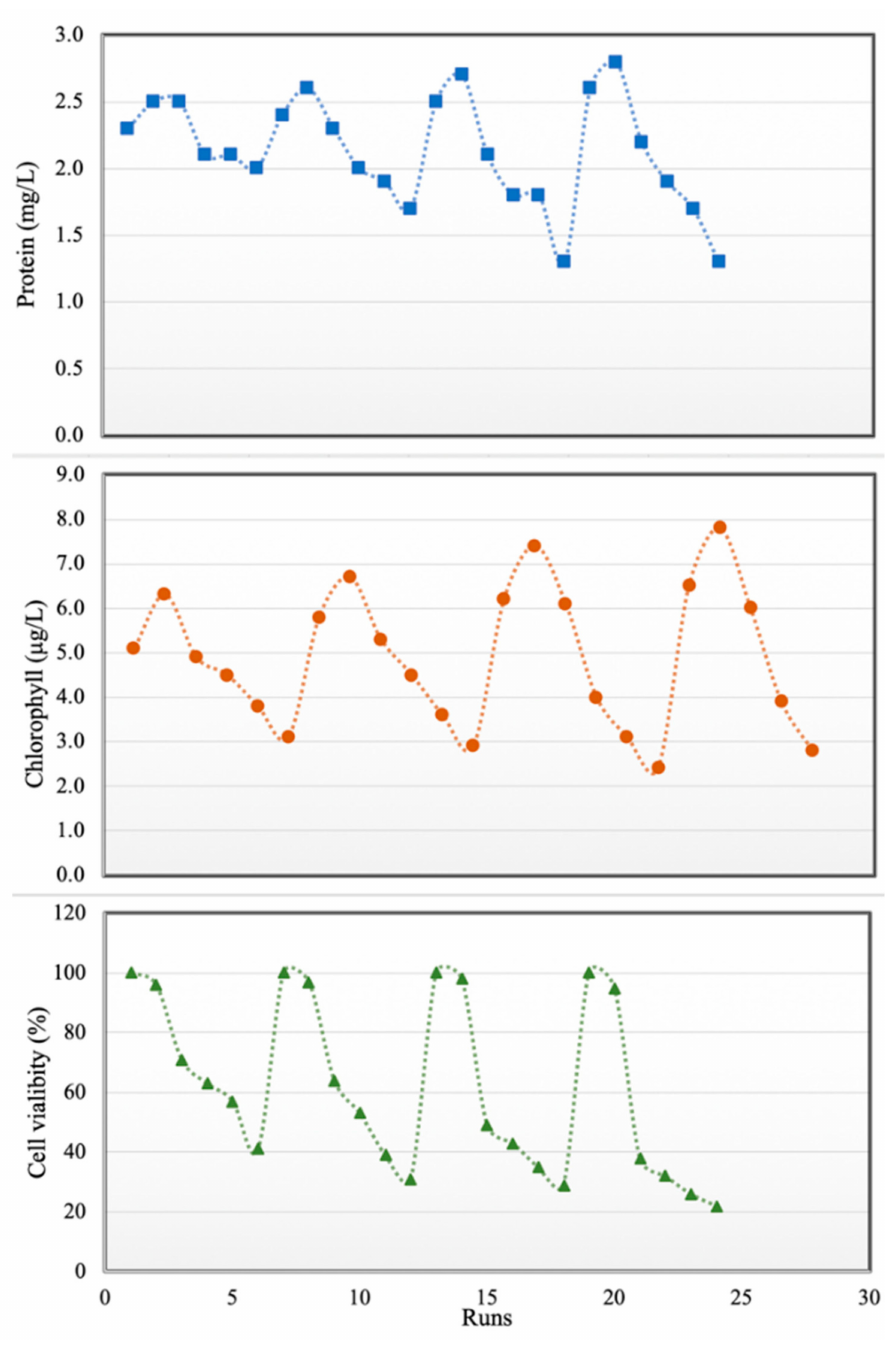
Figure 6. Effects of PPCPs on proteins ( top ), total chlorophyll ( middle ) and cell viability ( bottom